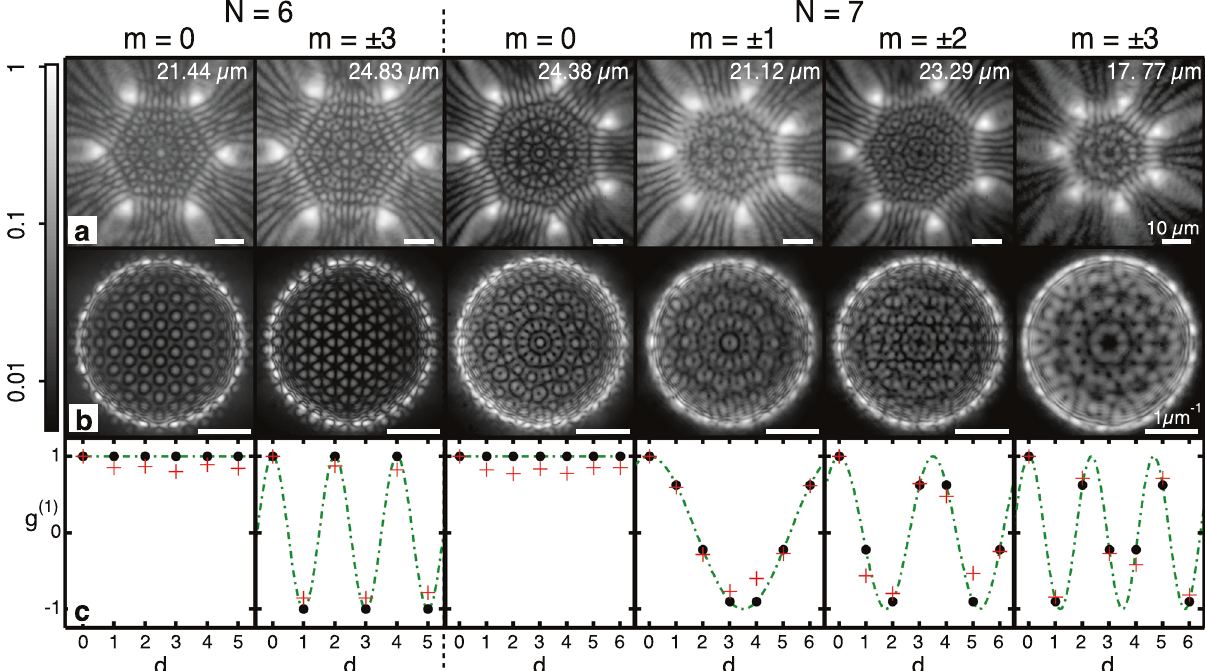
Fig. 2 Extraction of the g (1) from stationary and circulating states in both a hexagon and heptagon. a , b Real- and Fourier-space PL imaging of a hexagon and heptagon in different coupling con fi gurations achieved by tuning the polygon radius. Two leftmost columns show condensation of a hexagon into in- phase ( m = 0) and anti-phase ( m = 3) con fi gurations, whereas four rightmost columns show in-phase ( m = 0) and vortex formation ( m = ± 1, ±2, ±3) of a heptagon. c Extracted (red crosses) and calculated (black dots) mutual fi rst-order coherence g (1) versus parameter d extracted from the interferogram between condensates for different polygon con fi gurations. The values of g (1) lie upon the continuous function (green dot-dashed line) given by g ð 1 Þ ð x Þ ¼ cos ð 2 π mx = N Þ , where x has replaced the discrete parameter d . The point at d = 0 corresponds to the autocorrelation of the condensate wavefunction at zero time delay and is set as g (1) (0) = 1. The radii of the polygons are written in the top left hand corner of the real-space images in a . All real- and Fourier-space images are plotted on the same scale de fi ned on the scale bar at the end of each